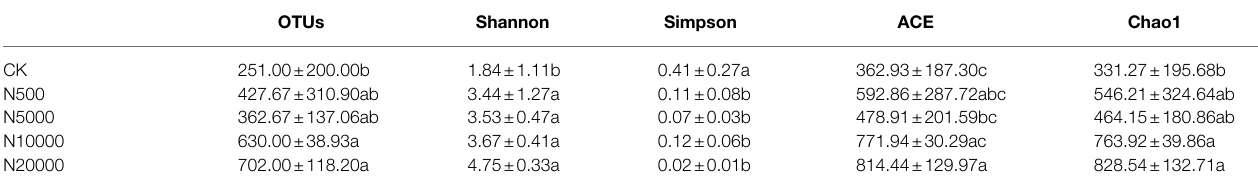
TABLE 1 | Diversity differences of the bacterial communities in layer manure samples. OTUs Shannon Simpson ACE